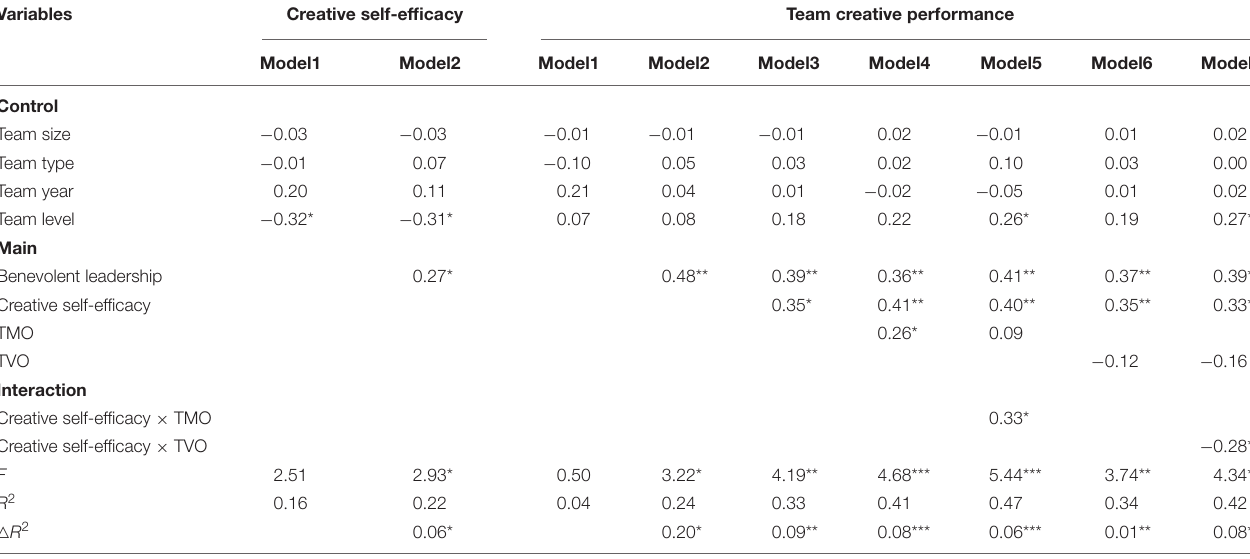
TABLE 2 | Moderated regression results for team openness to experience with team creative performance.